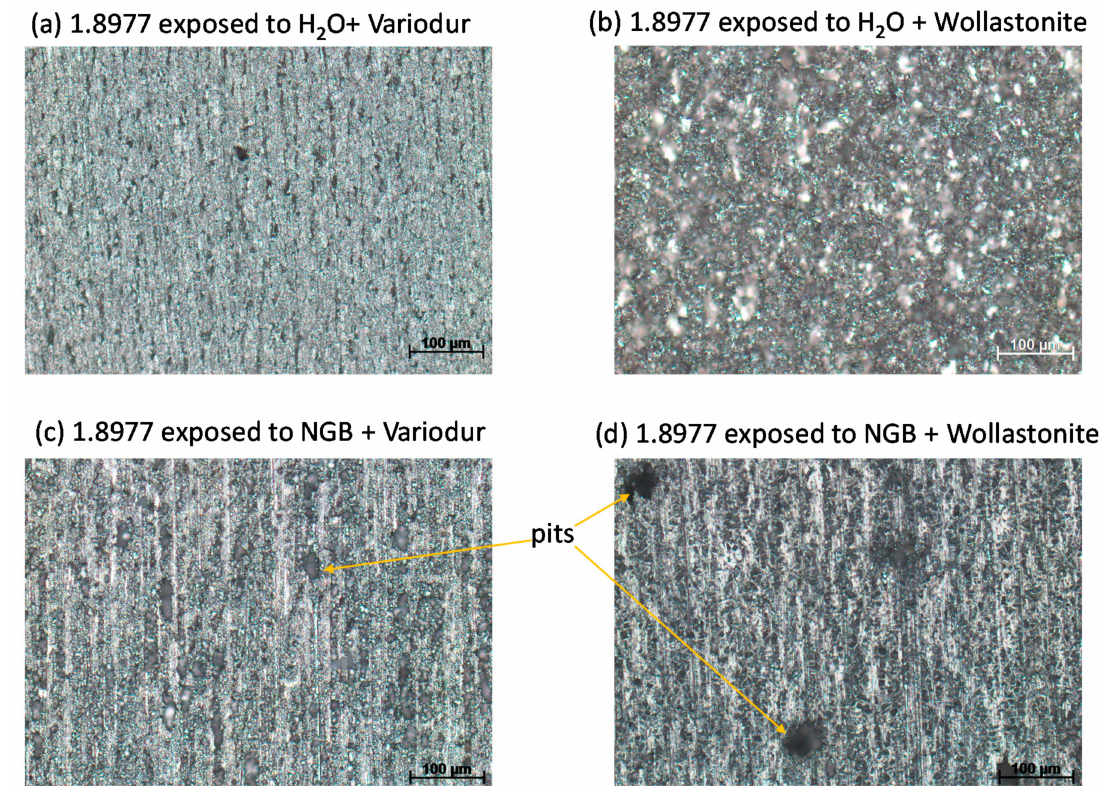
Figure 15. Stereomicroscope images showing the effect of cement on the pitting behavior of 1.8977 in simulated pore water mixed with ( c , d ) and without ( a , b ) aquifer fluid